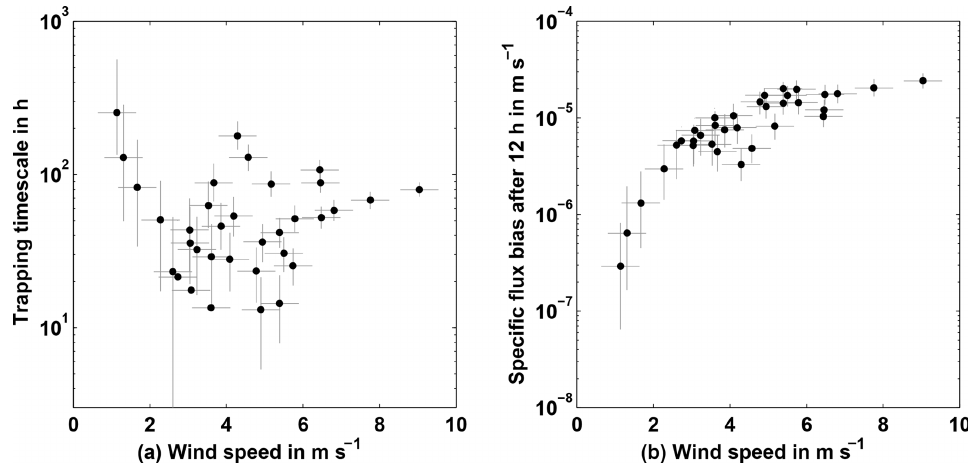
Figure 12. Trapping timescale TLD (a measure of trapping needed to reach a certain R ) as a function of wind speed u 10 (a) , and specific k w flux bias B = k w · R for R after 12 hours of trapping as a function of wind speed u 10 (b) . The shape of B(u 10 ) is very robust to varying R + 1 trapping times. R and B are based on the relation between wind speed u 10 and TLD as observed during the glider mission (Fig. 8). A complete shutdown of N 2 O supply to the TL from below is assumed, as is transfer velocity following Nightingale et al. (2000).